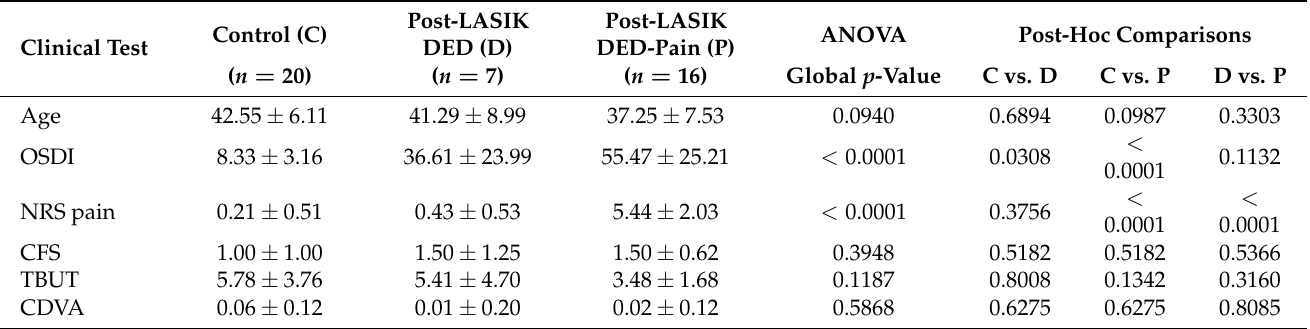
Table 1. Outcomes of the subjective and objective tests